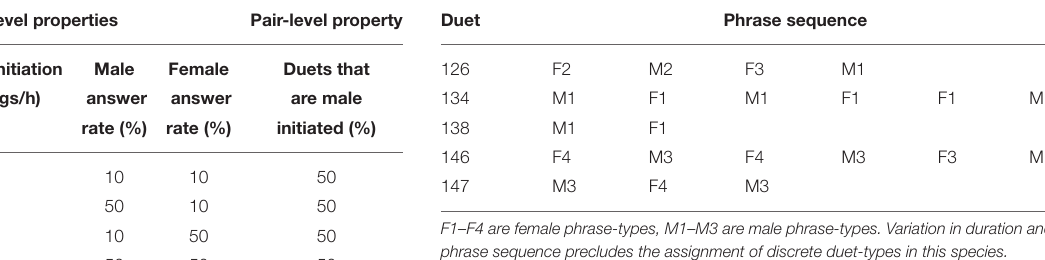
TABLE 2 | Phrase-type sequences representing five duets from one mated TABLE 1 | A sample of individual-level property sets that produce an pair of black-bellied wrens ( Pheugopedius fasciatoventris ). equivalent percentage of male initiated duets. Individual-level properties Pair-level property Duet Phrase Duets that